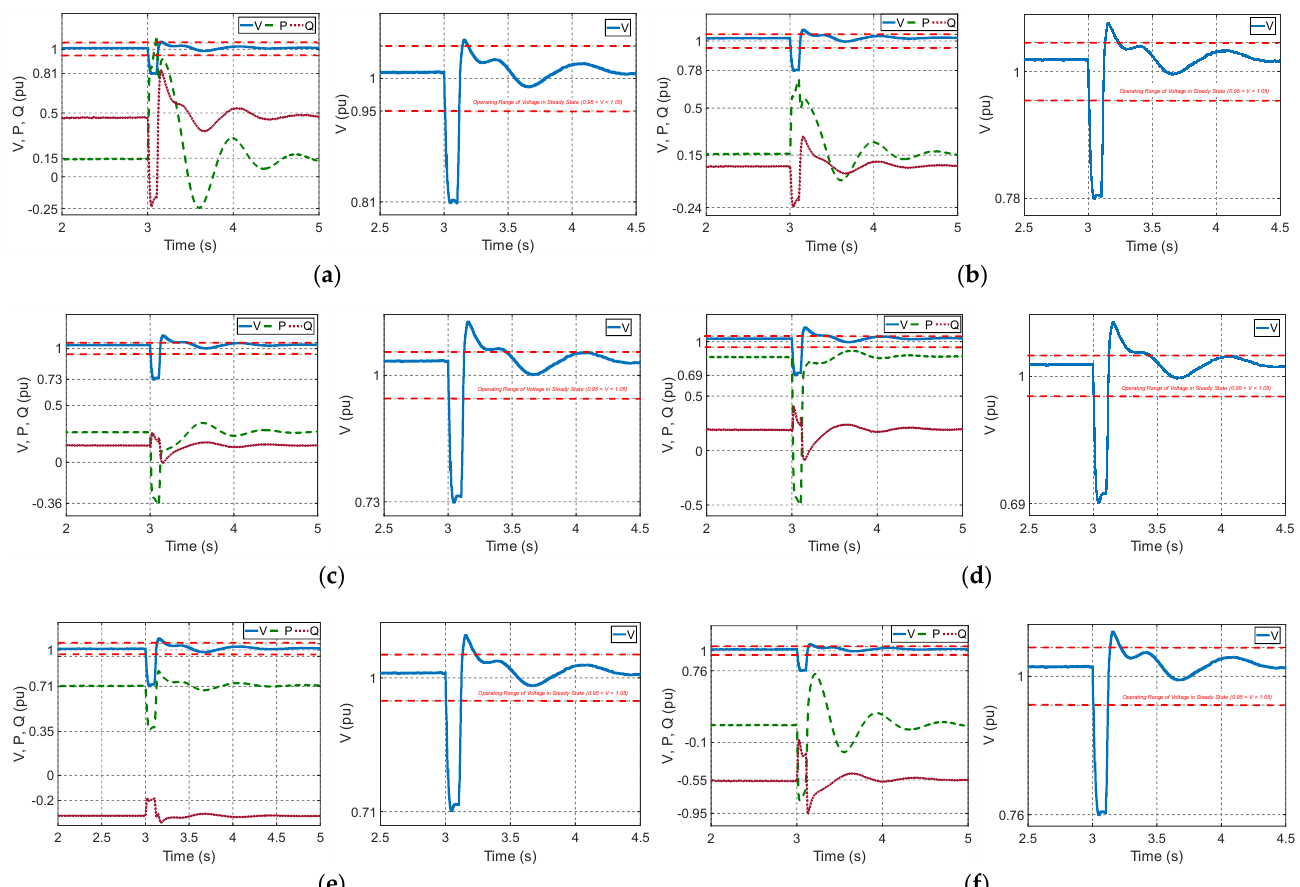
Figure 11. Scenario 1, results for the system buses: voltage (V), active power (P), reactive power (Q), and voltage zoom. ( a ) Bus 1; ( b ) bus 2; ( c ) bus 3; ( d ) bus 4; ( e ) bus 5; ( f ) bus 6.